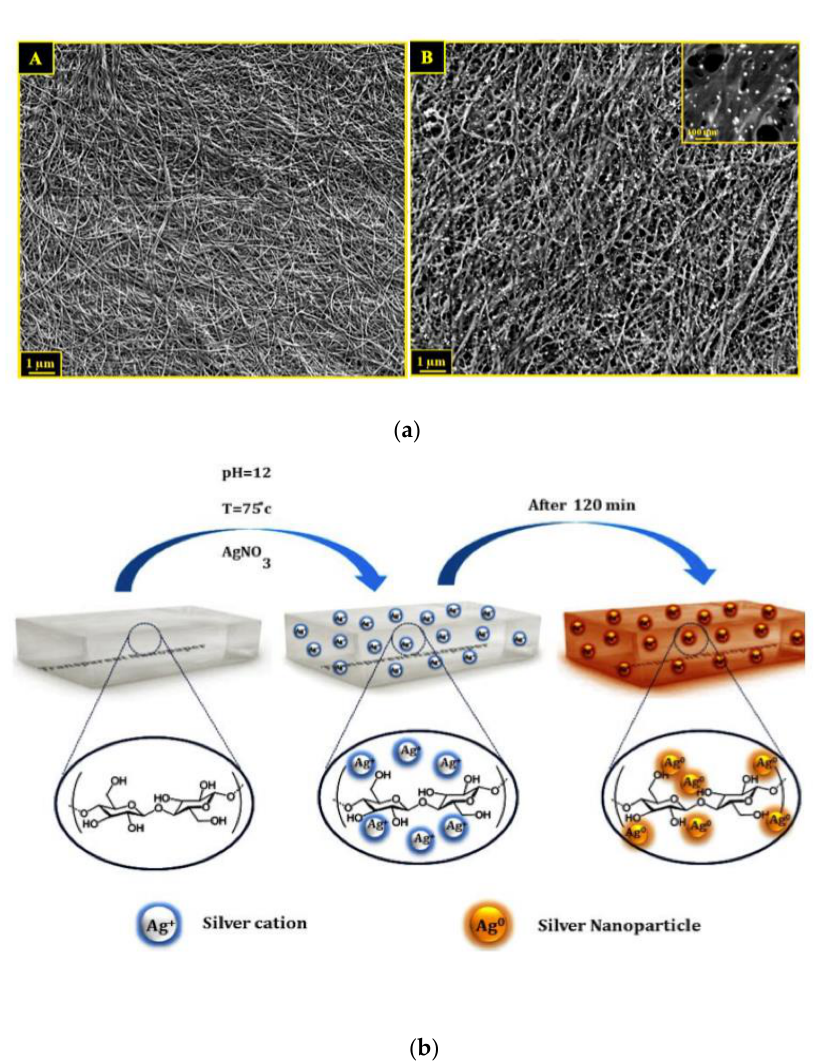
Figure 4. Modified BNC prepared by agitation method for incorporation of nanoparticles. ( a ) ( A ) Field Emission Scanning Electron Microscopy (FE-SEM) images of transparent nanopaper. ( B ) FE- SEM images of ESNP; ( b ) Schematic representation for the fabrication of ESNPs. Adapted with per- mission from [94]. Copyright 2015. Reproduced with permission from